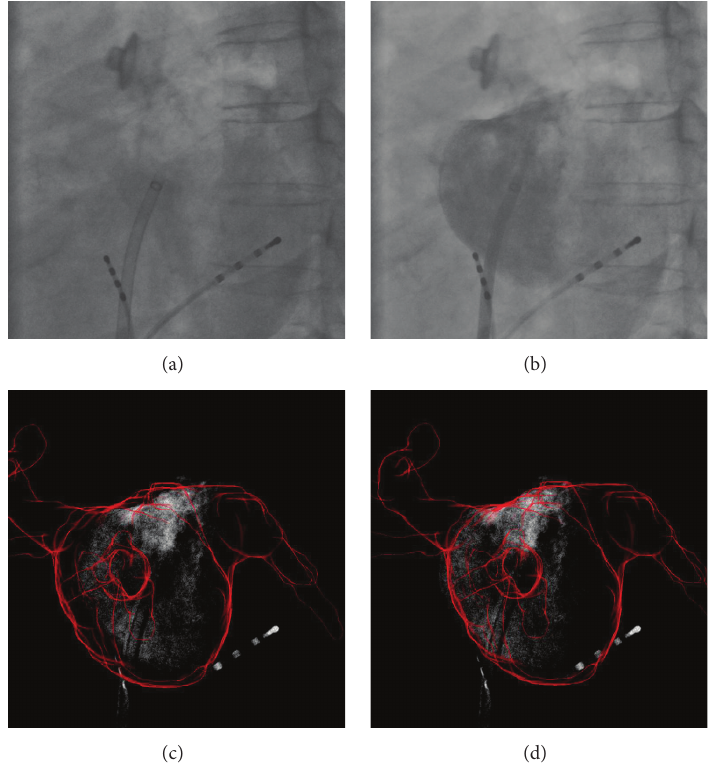
Figure 7: Uncontrasted (a) and contrasted (b) frame of an X-ray angiography. The registration result when using 𝜌 DSA + 𝜌 (d), the left border of the LA model fits better to the left edge of the CA and the error reduced to 3.1mm. 6.7 mm. By using 𝜌 CADE edge